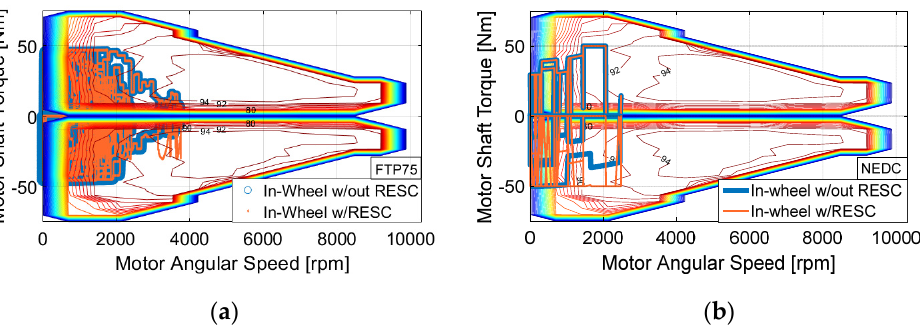
Figure 8. In-wheel motor with and without regenerative electronic stability control (RESC) for ( a ) the FTP75 and ( b ) NEDC.